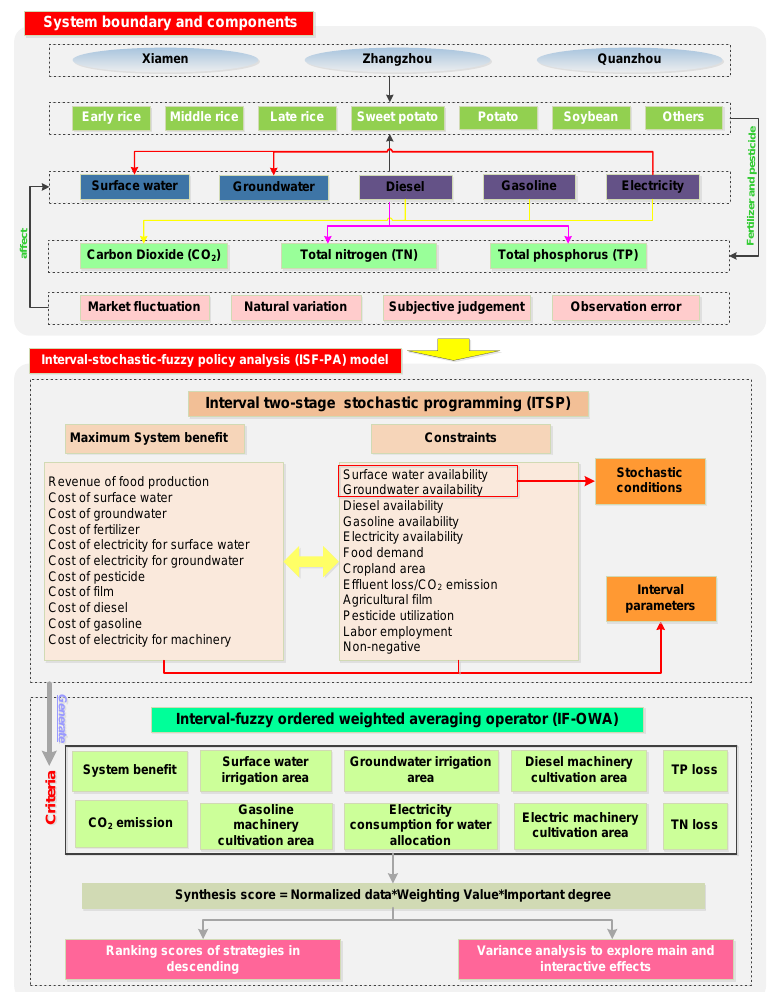
Figure 2. Framework of the interval-stochastic-fuzzy policy analysis (ISF-PA) model.